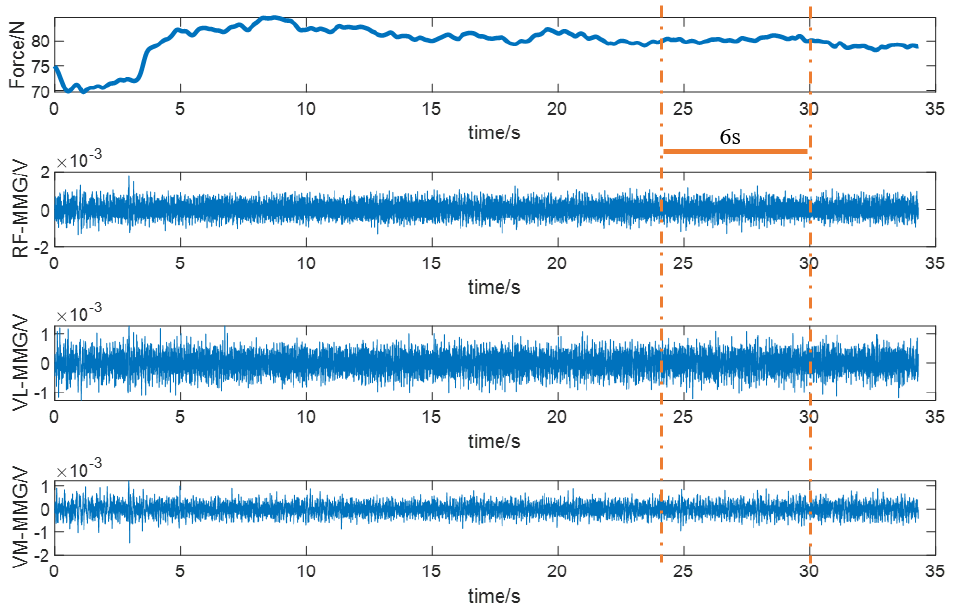
Figure 4. Signal and data selection after preprocessing.